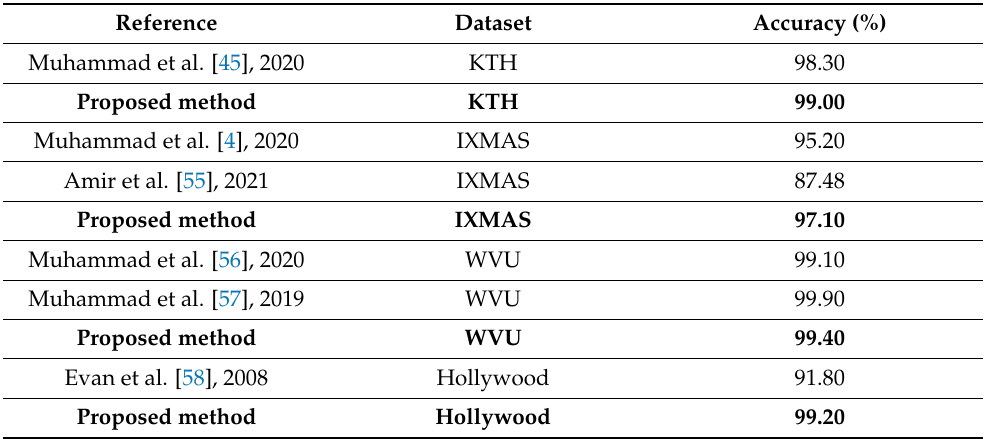
Table 11. Comparison of the proposed design with existing techniques in terms of accuracy. The bold represents the best obtained